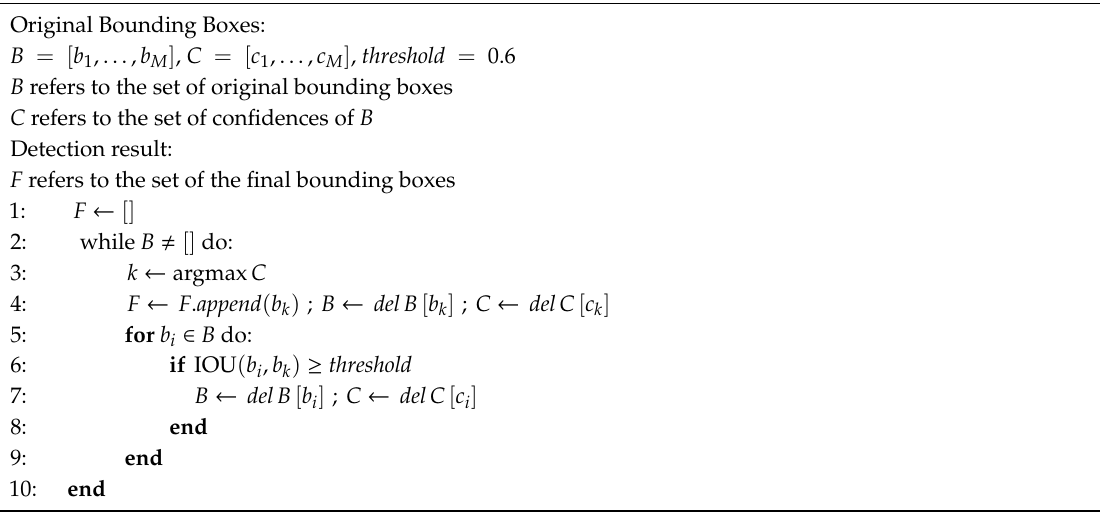
Algorithm 2: The pseudocode of non-maximum suppression (NMS) for our approach